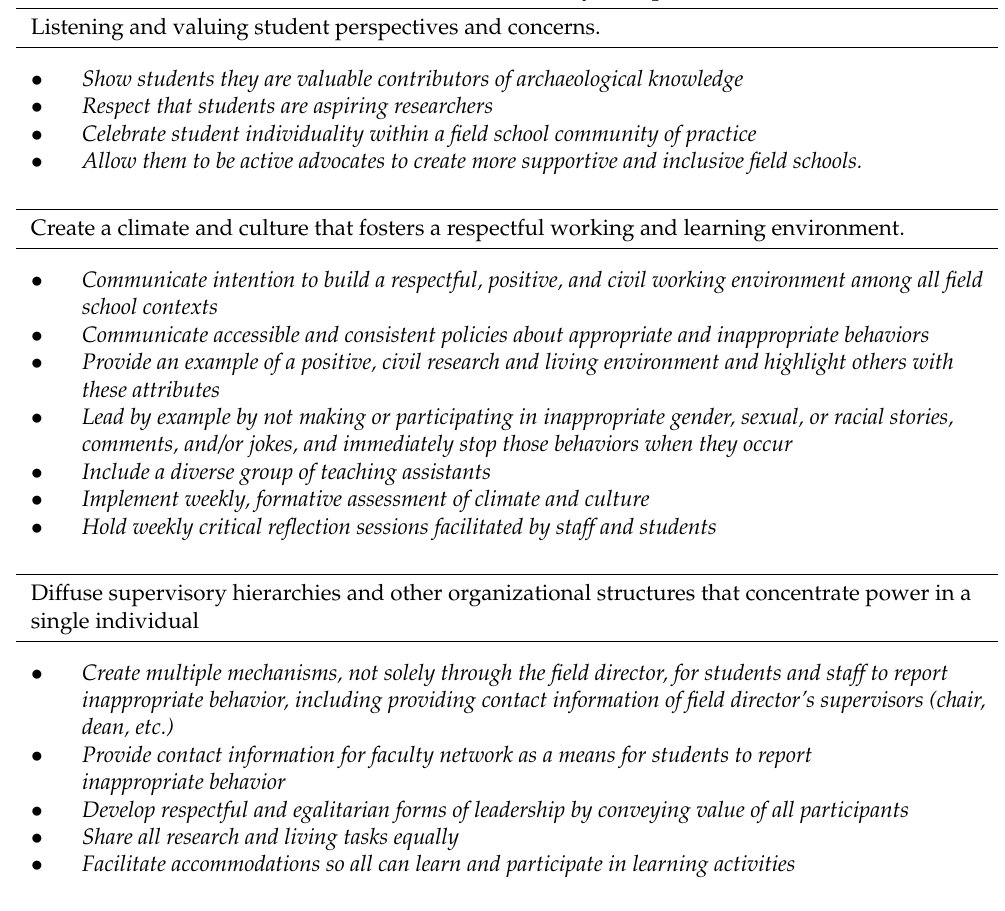
Table 1. The five factors found among archaeological field schools, adapted from [9] (Table 2) (Reprinted/adapted with permission from Ref. [9]. 2020, Society of American Archaeology). Recommendations and Summary of